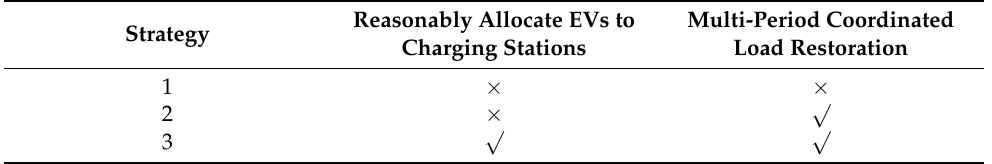
Table 2. The differences among the three